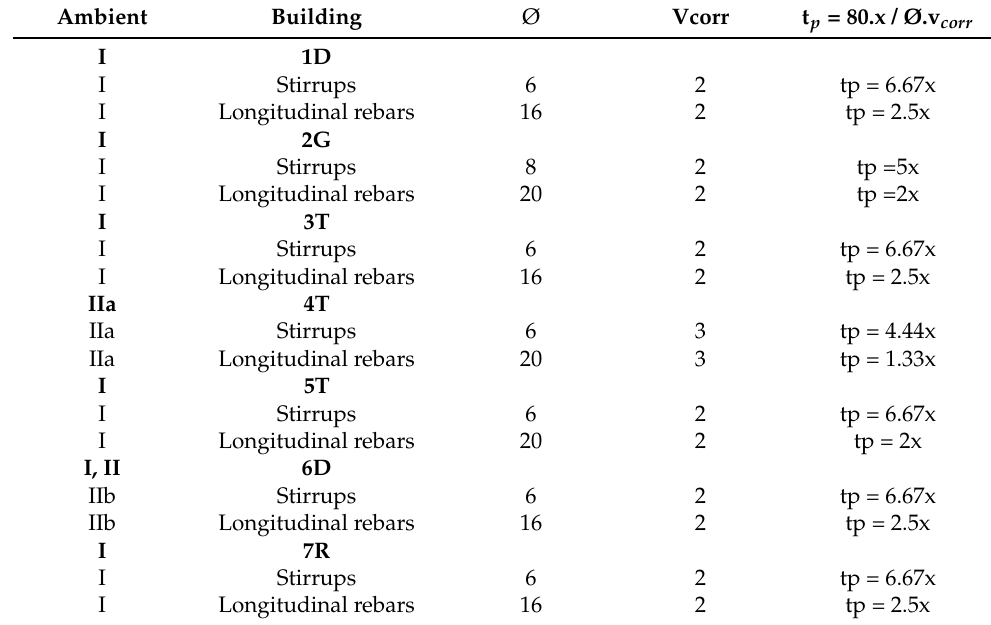
Table 5. Model of the corrosion propagation period in each